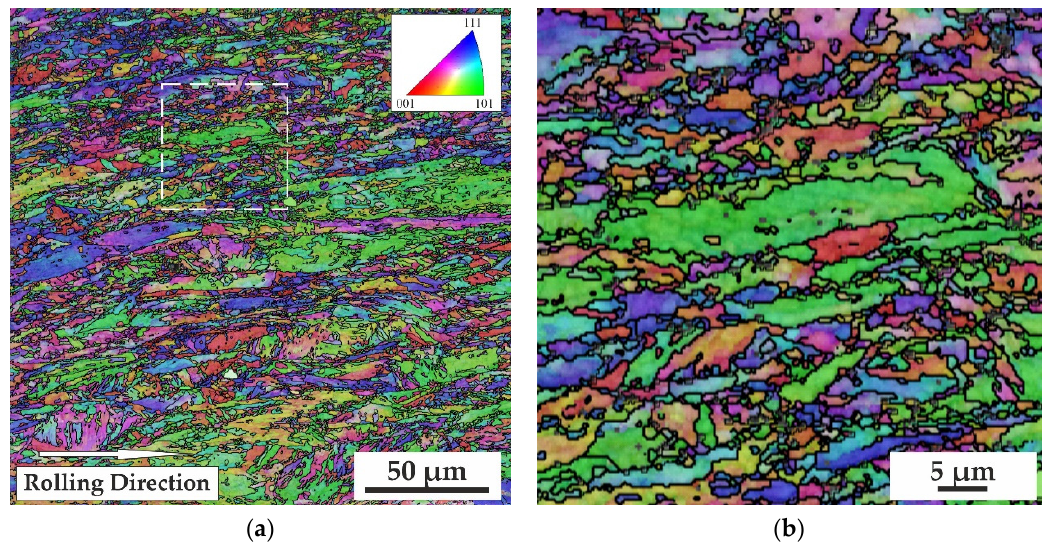
Figure 3. SEM EBSD images of steel microstructure after HTMT in the longitudinal section. Orien- tation map with a dashed-line square region ( a ). Magnified image of this square region ( b ).